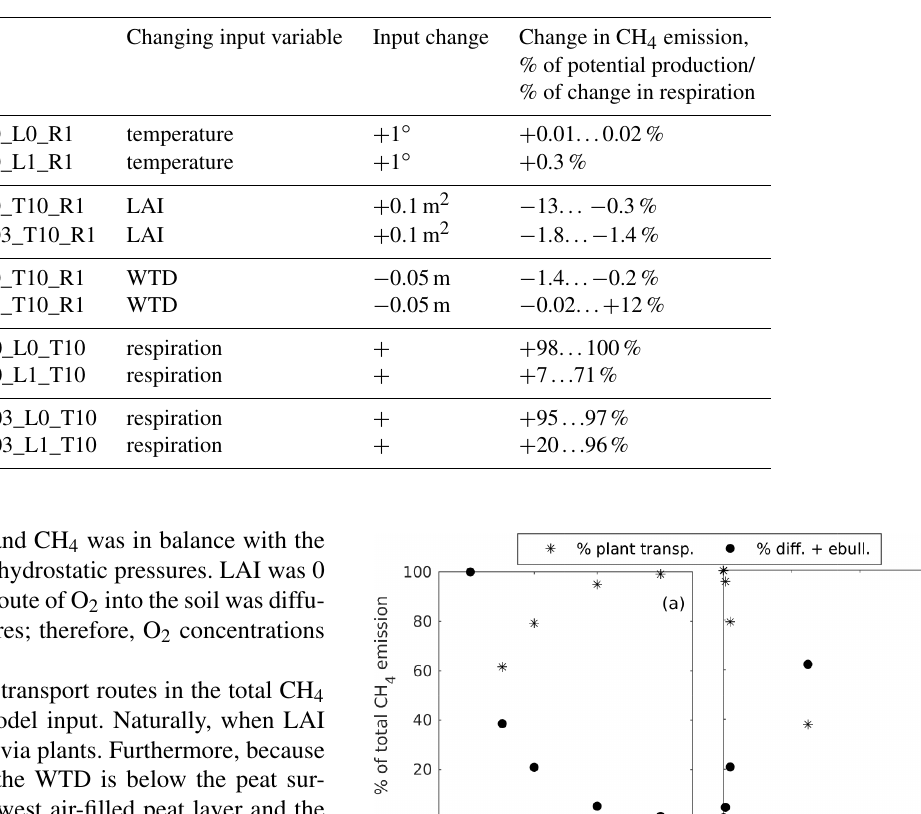
Table 4. Results of the sensitivity testing. The rightmost column tells how much the CH 4 emissions changed when the input changed. The ± signs in front of “input change” and “change in CH 4 emission” show the directions of change in input and the corresponding response in CH 4 emissions. This is expressed as percentage of PMP (see Sect. 3.1.3) for the first six tests and as percentage of change in input anoxic respiration for the tests on changing input respiration. In most cases, the response was not constant over the input range, and therefore the result is also expressed as a range.